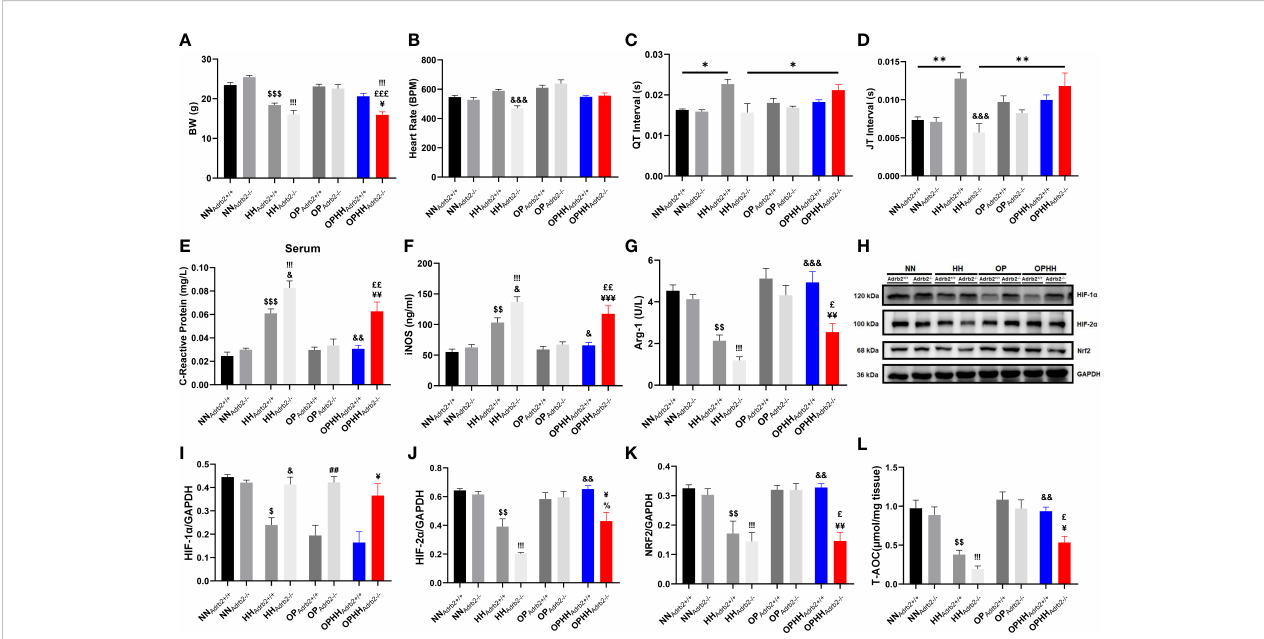
FIGURE 7 b 2 AR is implicated in OP-induced adaptive responses against hypobaric hypoxia (A) Graphical presentation of Body weight (BW) alteration trends among Wild type (Adrb2 +/+ ) and b 2 AR knockout (Adrb2 -/- ) mice in experiment groups; Normobaric Normoxia (NN), Hypobaric Hypoxia (HH), Altitude Preconditioned (AP), Altitude Preconditioned before HH exposure (APHH), Occlusion Preconditioned (OP) and Occlusion Preconditioned before HH exposure (OPHH) (n=5-15 mice per group). (B-D) Graphical presentation of electrocardiogram (EKG) indexes, including; Heart Rate, QT Interval, and JT interval (n=5-9 mice per group). (E-G) In fl ammatory biomarker; C-reactive protein, Inducible nitric oxide synthase (iNOS), and Arginase-1 (Arg-1) concentrations assessed by ELISA. Assays were performed in triplicates (n=4 mice per group). (H-K) Representative Immunoblotting of Hypoxia-inducible factors (HIF)-1 a , HIF-2 a , and nuclear factor erythroid 2 – related factor 2 (Nrf2), and their respective Graphical plots; each blot band in the representative blot is an independent biological sample (n= 3 hearts per group). (L) Graphical plots of the concentrations of Total antioxidant capacity (T-AOC) of myocardia (n=4 hearts per group). $ p<0.05, $$ p<0.01, $$$ p<0.001 vs NN & p<0.05, && p<0.01, &&& p<0.001 vs HH ## p<0.01 vs OP ¥ p<0.05, ¥¥ p<0.01, ¥¥¥ p<0.001 vs Adrb2+/+ ; Adrb2+/+ ; Adrb2+/+ ;